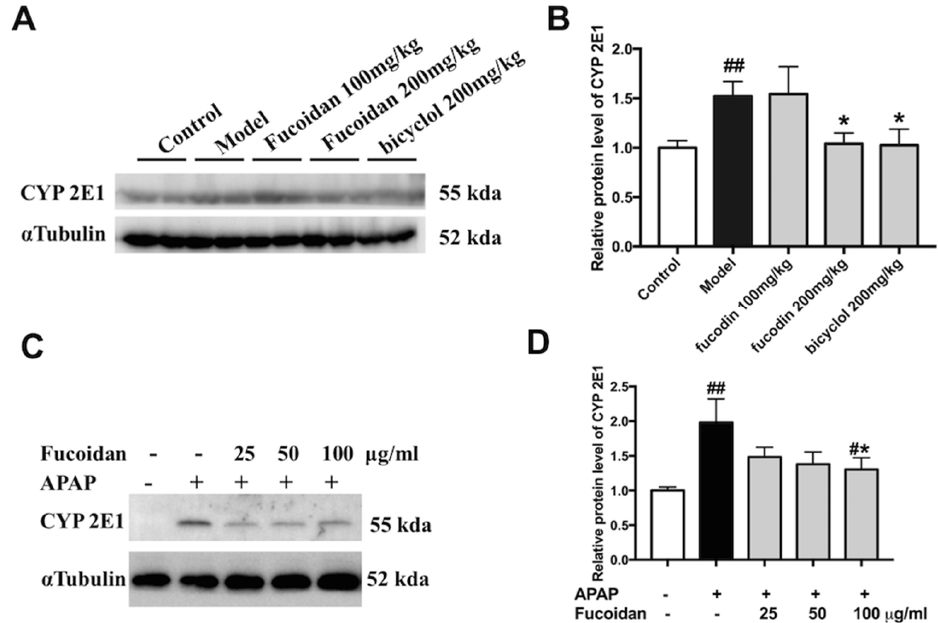
Figure 6. Effect of fucoidan on protein expression of CYP2E1 following an APAP overdose. ( A ) Representative blots of CYP2E1 and α Tubulin expression in hepatic tissues. ( B ) Quantification of CYP2E1 protein levels in liver tissues ( n = 6). ( C ) Representative blots of CYP2E1 and α Tubulin expression in HL-7702 cells. ( D ) Quantification of CYP2E1 protein levels in HL-7702 cells ( n = 3). Similar results were obtained from three independent experiments. All results were expressed as mean ± SD, ## p < 0.01 versus control group; * p < 0.05 versus APAP-treated group.